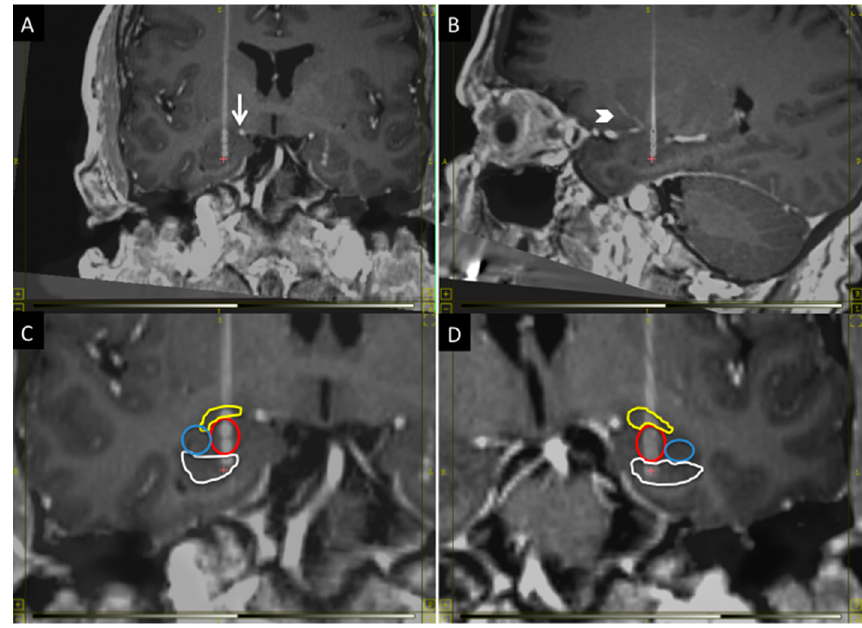
Figure 1. The figure shows the anatomical position of the BLn electrodes in the coronal plane ( A , C , D ) and sagittal plane ( B ): ( A ) The electrode must avoid the superior extent of the ambient cistern (arrow); ( B ) and the lenticulostriate vessels (arrowhead); ( C , D ) respectively show the right and left Bln electrodes with segmentation of the nuclei: in yellow, the central nucleus; in red, the basolateral nucleus; in blue, the lateral nucleus and, in white, the head of the hippocampus. The electrode contact distribution, from dorsal to ventral: Central nucleus (one contact); BLn (two contacts); Hippocampus (one contact). Laterally: Lateral nucleus (zero contacts).